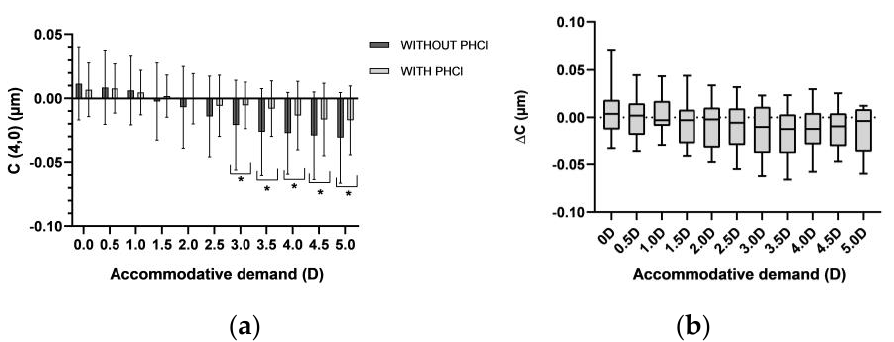
Figure 5. ( a ) Primary spherical aberration Zernike coefficients for the different target accommodations, with and without PHCl (grey and black bars, respectively). ( b ) Box plot of the difference in Zernike coefficients between natural conditions and after instillation of PHCl for each accommodative demand. * Denote statistically significant values ( p < 0.05). Error bars represent the standard deviation (SD).